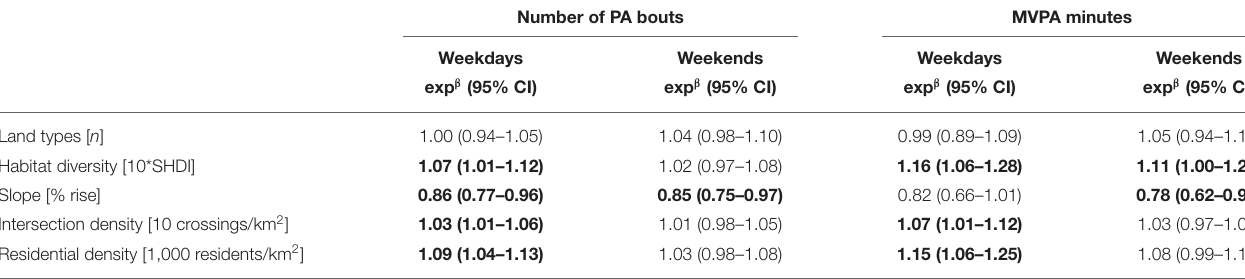
TABLE 3 | Associations of environmental features with PA bouts and MVPA on weekdays and weekend days ( n = 167).